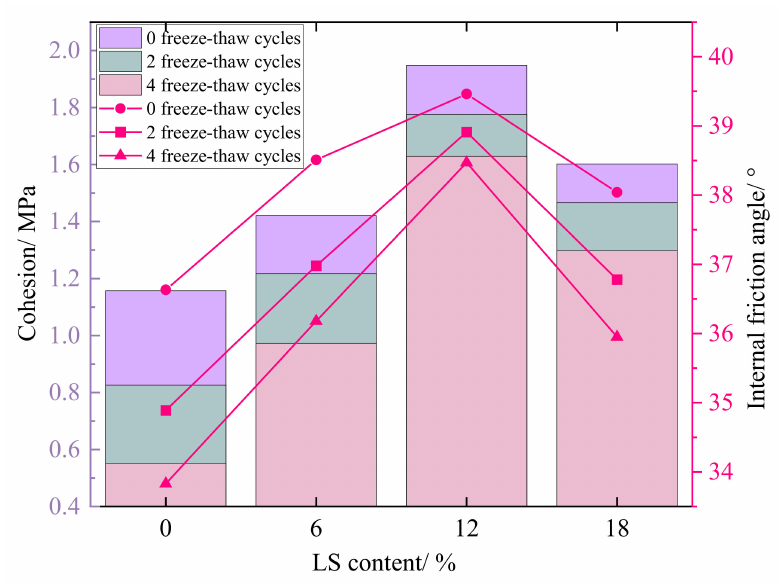
Figure 11. Effect of LS content on unconfined compression strength of cement-soil after freeze– thaw